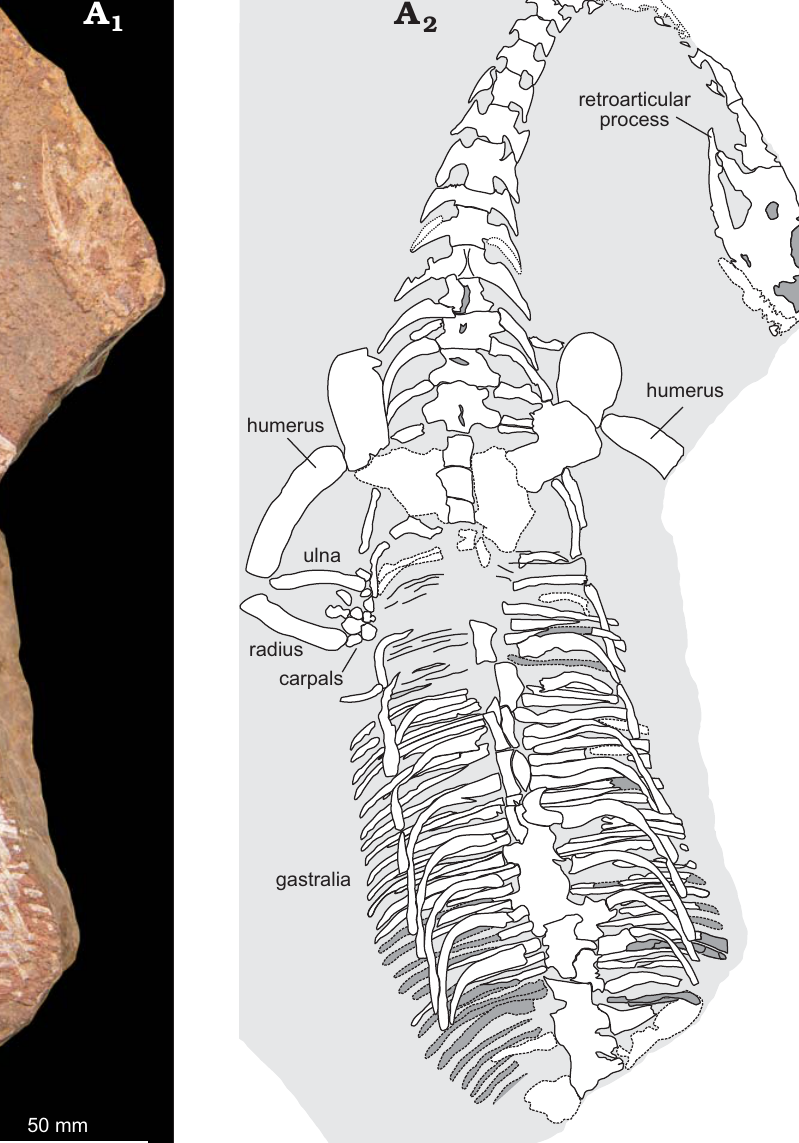
) and explanatory drawing (A ). For measure- 1 2